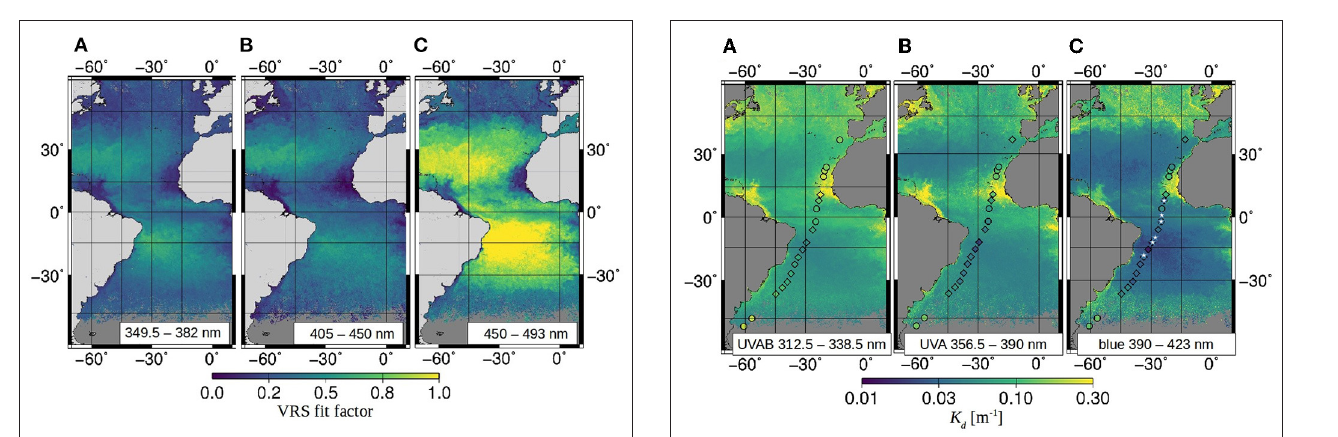
different fit windows are not strictly correlated, e.g.,